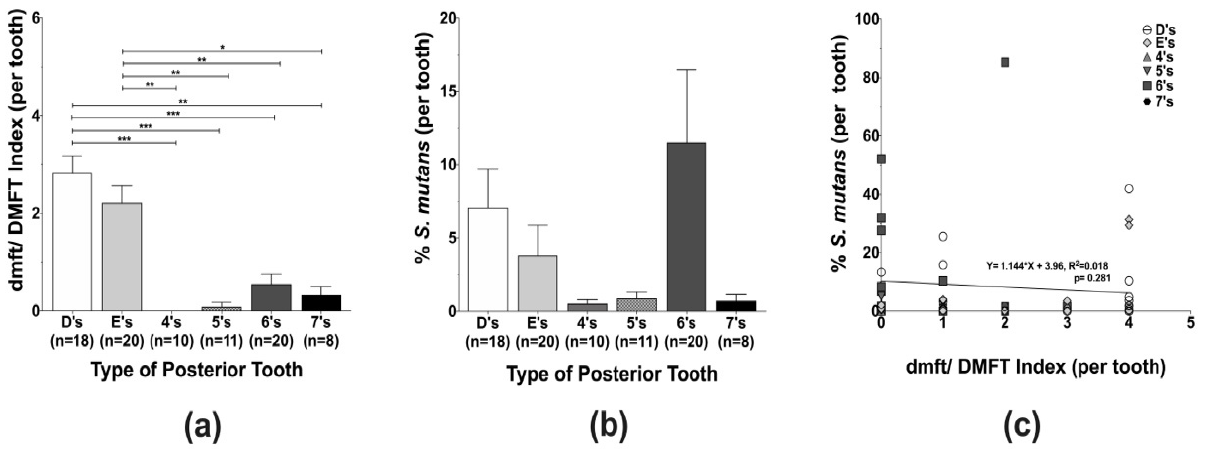
Figure 1. Caries experience and Streptococcus mutans levels quantification among posterior tooth in different dentition stages. ( a ) The individual posterior tooth (D’s, E’s, 4’s, 5’s, 6’s, and 7’s) caries status was assessed using decayed, missing, and filled tooth (dmft/DMFT) criteria, and the figure represents the average caries experience per tooth type. ( b ) S. mutans levels were evaluated by qPCR using S. mutans -specific primers (Table 1). ( c ) Linear regression analysis of S. mutans levels and dmft/DMFT index. Differences in significance between groups were analyzed using one-way ANOVA followed by Kruskal–Wallis multiple comparisons tests; * p < 0.05, ** p < 0.005, and *** p < 0.0005.